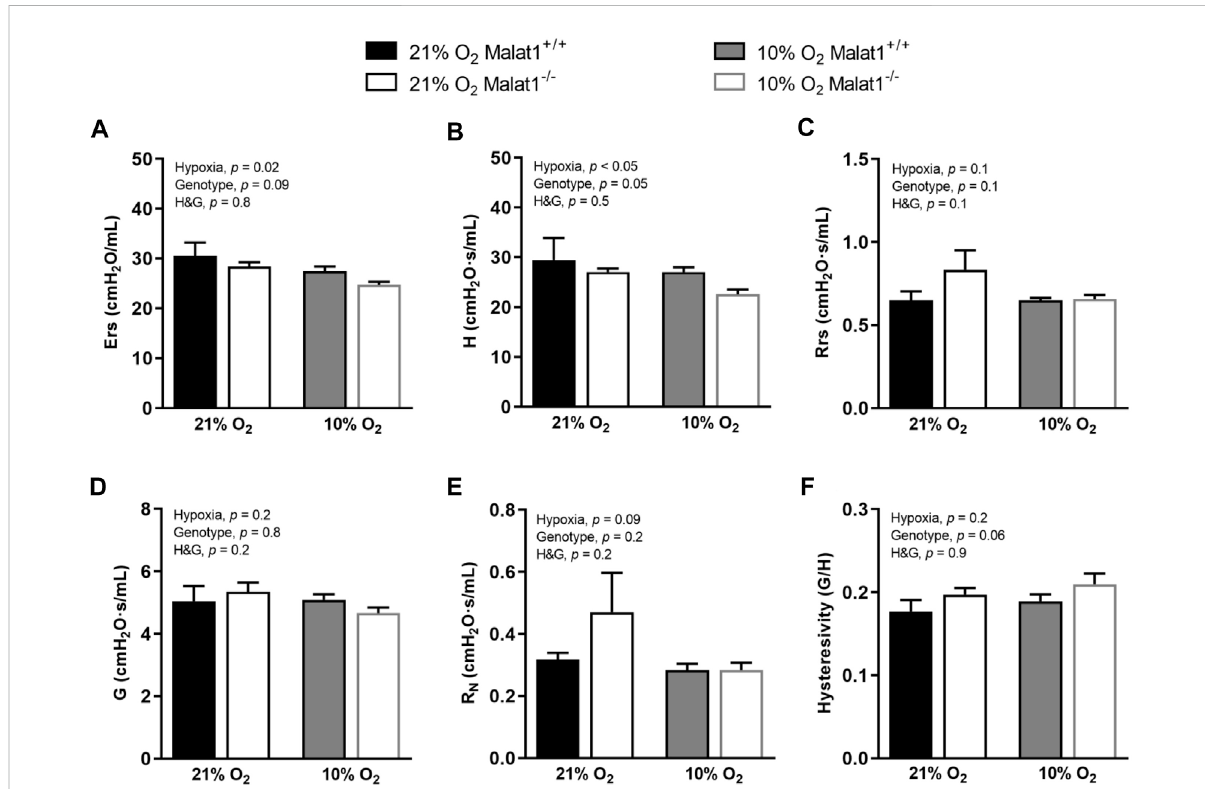
FIGURE 2 In vivo respiratory mechanics at baseline. (A) Respiratory system elastance (Ers), (B) tissue elastance (H), (C) respiratory system resistance (Rrs), (D) tissue resistance (G), (E) Newtonian resistance (R N ) and (F) hysteresivity (G/H = η ) in Malat1 +/+ and Malat1 − / − mice housed in normoxia or hypoxia for 8 days. n = 5, 8, 9 and 8 for Malat1 +/+ in normoxia, Malat1 − / − in normoxia, Malat1 +/+ in hypoxia and Malat1 − / − in hypoxia groups, respectively. Data were analyzed by two-way ANOVA. * p = 0.05, ** p = 0.001, *** p <